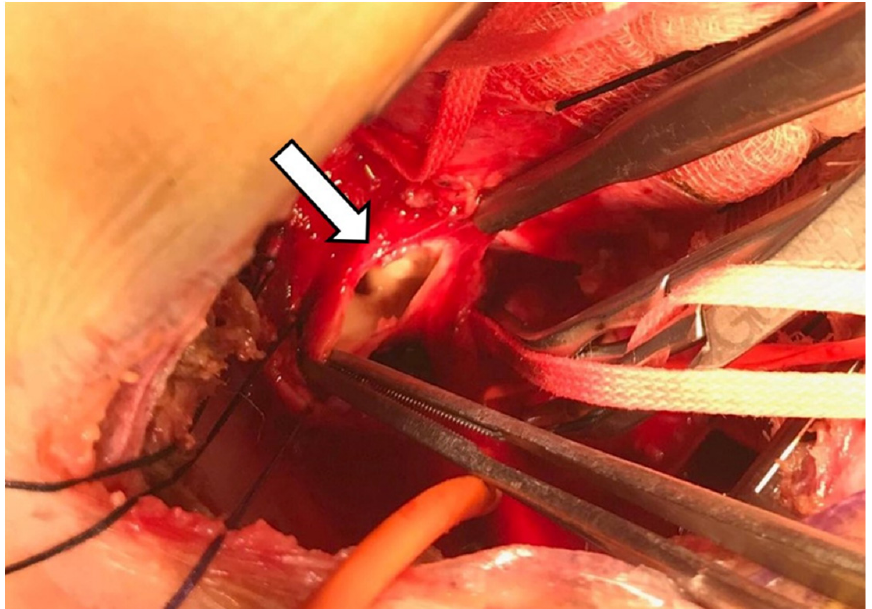
Figure 3. Intraoperative photo revealing the aorto ‐ esophageal fistula ( arrow ).